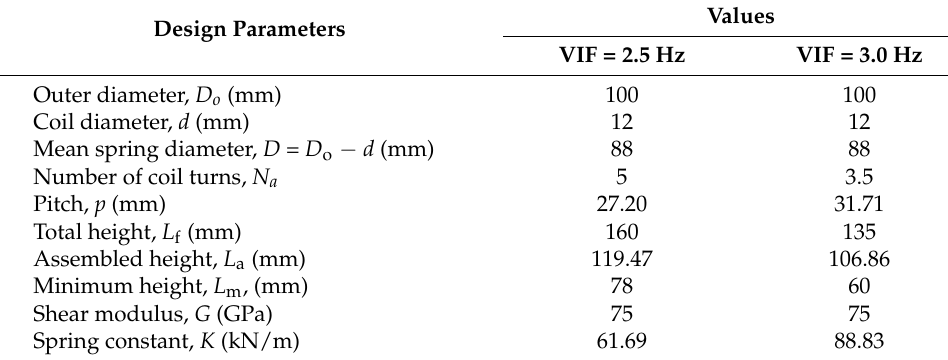
Table 8. Summary results of final design parameter values for a single helical coil spring.